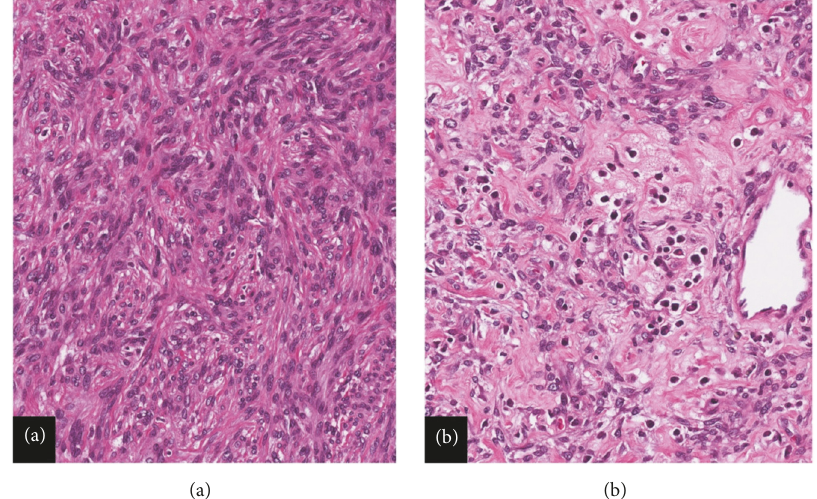
Figure 3: (a) Histology: spindle cell neoplasm with sheet-like growth and syncytial cytoplasmic appearance (Hematoxylin & eosin, 20X). (b) Histology: scattered intrinsic lymphocytes and plasma cells (Hematoxylin & eosin, 20X).